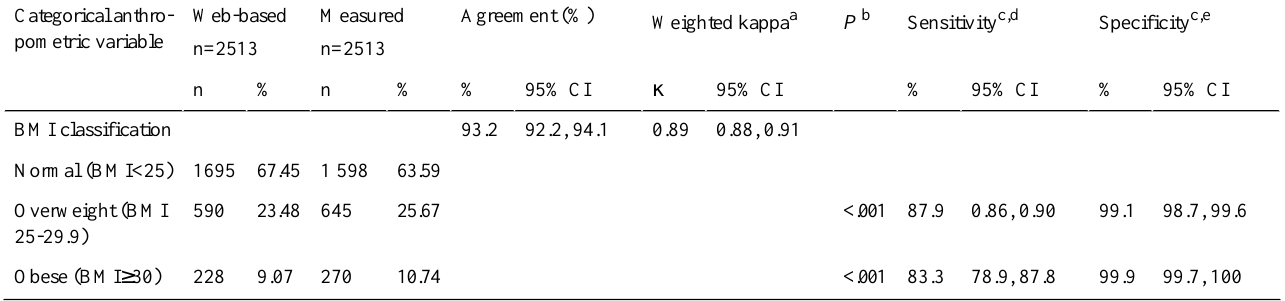
Table 3. Validity indicators for categorical variables including percent of similar classification and weighted kappa coefficient for overweight and obesity classification between the Web-based declaration and reference measurement at clinical examination from the NutriNet-Santé Study, 2012, France